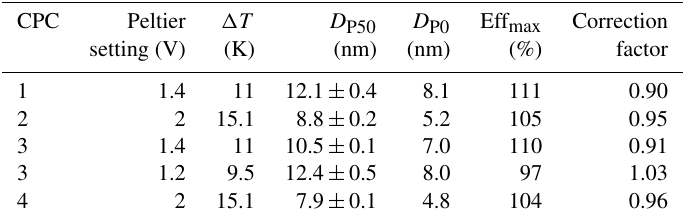
Table 2. Calibration results of four CPC 3007 for different Peltier voltage settings. The correction factors account for offsets in sample flow rates from the customized flow system and reduced supersaturation in the case of CPC3 at 1.2V. Uncertainties for the D P50 are derived from a non-linear regression